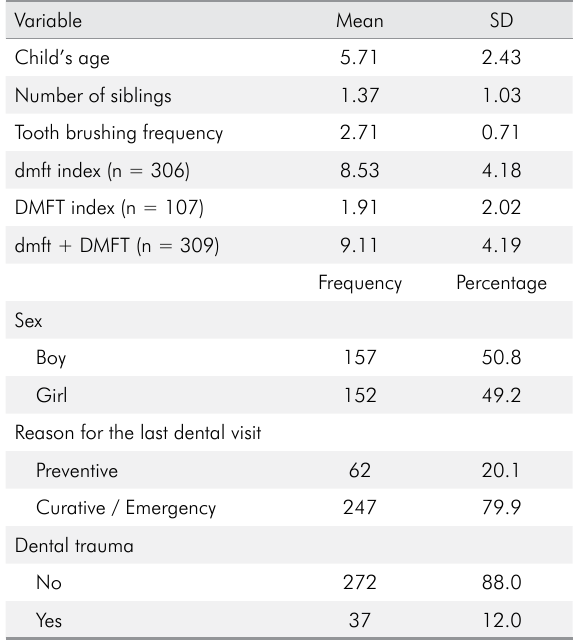
Table 1. Descriptive analysis of the independent